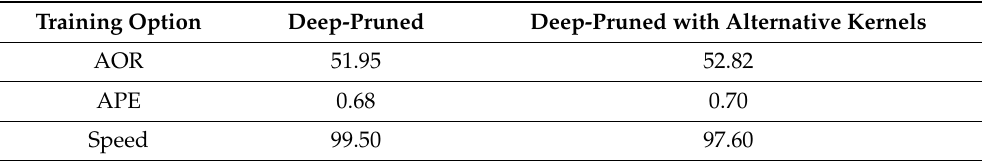
Table 3. AOR and APE, as well as speed of deep-pruned feature network or deep-pruned feature network with alternative kernels, on the OTB2013 dataset.